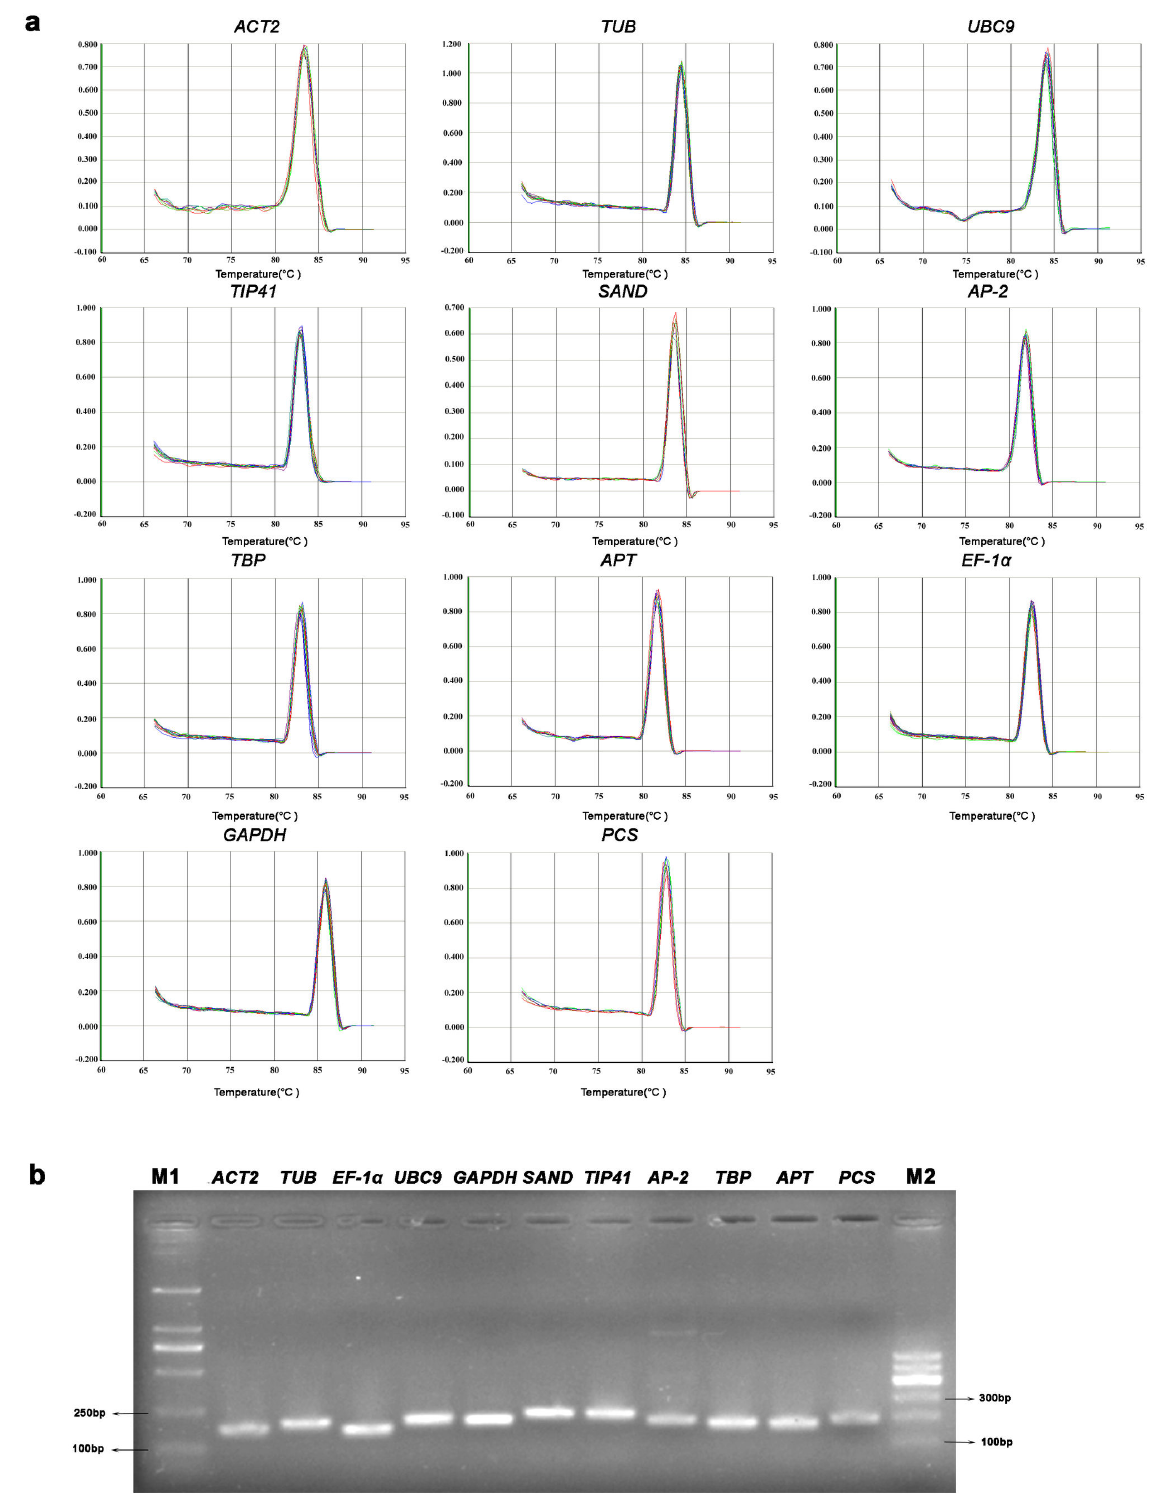
Figure 1. Confirmation of primer specificity and amplicon size. (a) Melting curves of ten candidate reference genes and one target gene showing single peaks. (b) Agarose gel (2%) showing specific RT-qPCR products of the expected size for each genes. M1 and M2 represent 2000bp and 500bp DNA marker respectively. doi: 10.1371/journal.pone.0082927.g001 PLOS ONE |